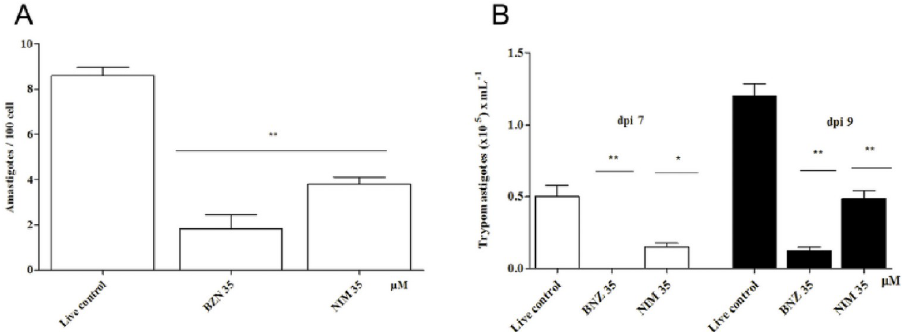
Fig 3. Infection of peritoneal macrophages in BALB/c mice with trypomastigotes, followed by treatment with benznidazole and nimesulide. A : Inhibition of amastigotes after 3 days of treatment. B : Release of trypomastigotes after 7 and 9 days of treatment. Representative results from two independent experiments. Both results were for two independent experiments. Asterisks represent the significant difference from the untreated control (p < 0.05).